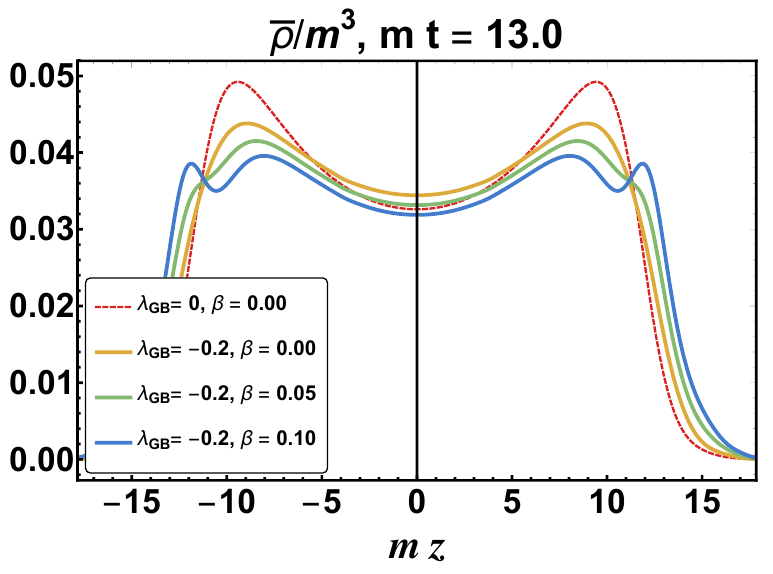
Figure 5 . (cid:12) -dependence of the baryon number density after a collision between thick sheets at the late time t = 13 =m with (cid:15) = 0, plotted as a function of mz .